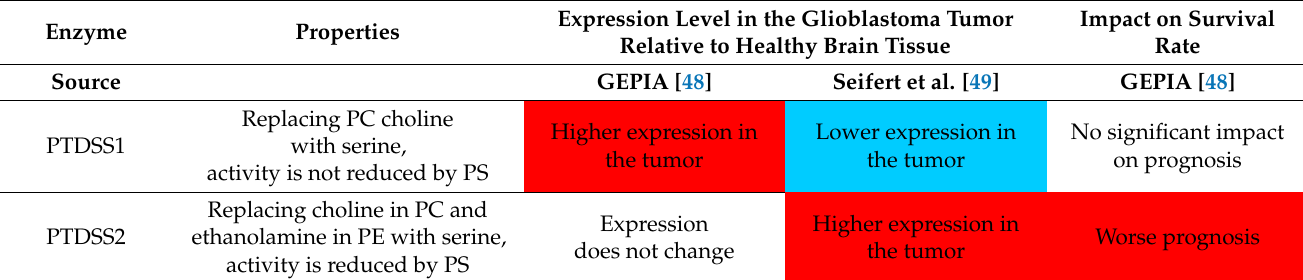
Table 9. Characteristics of enzymes involved in PS